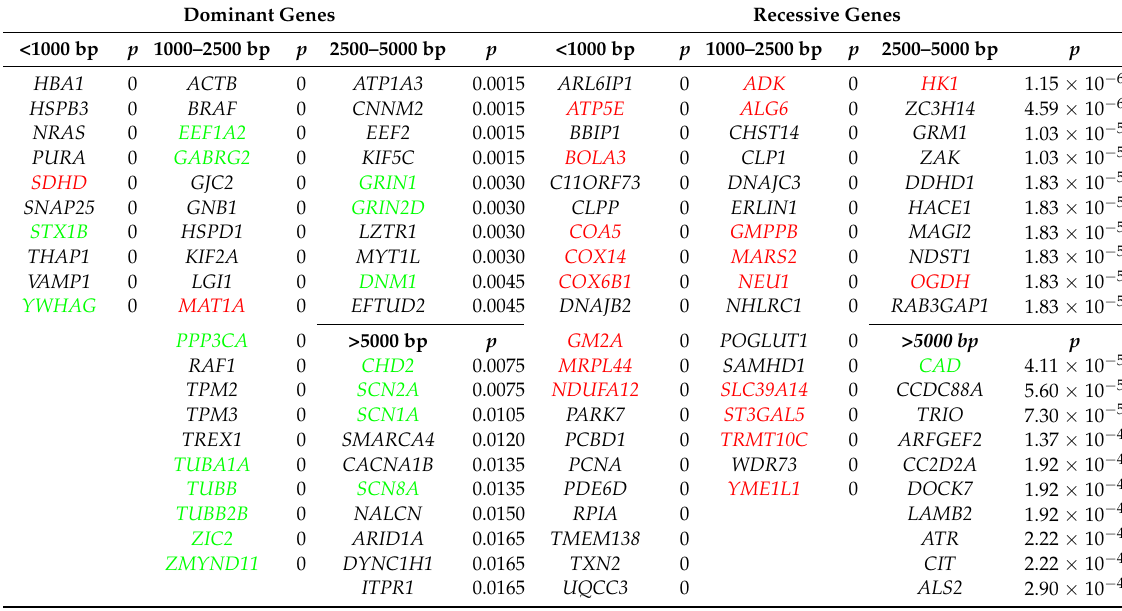
Table 2. Dominant ( left ) and recessive ( right ) genes for which the probability of finding one or two variants, respectively, was the lowest for the four different gene length sections. Red, genes associated with metabolism; green, genes associated with epileptic